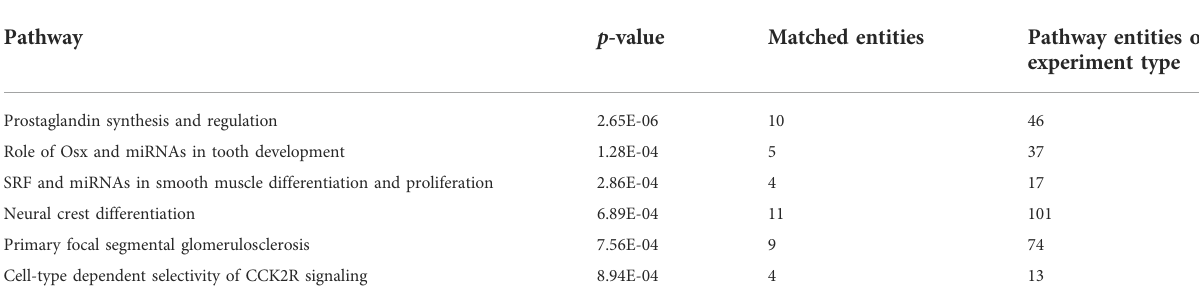
TABLE 3 Pathway enrichment in OFCD syndrome. Pathway p -value Matched entities Pathway entities of